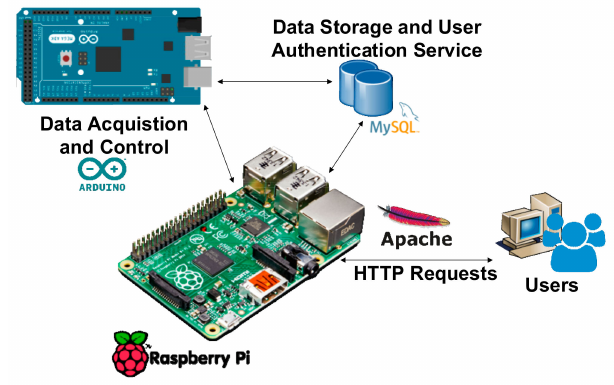
Figure 3. Control and management functional scheme of the microgrid laboratory demonstrator.